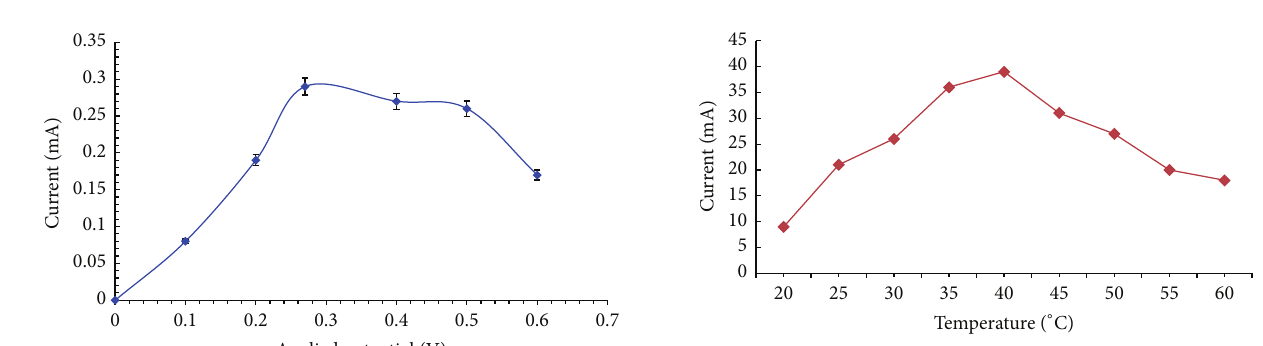
Figure 6: Response of current with applied potential.